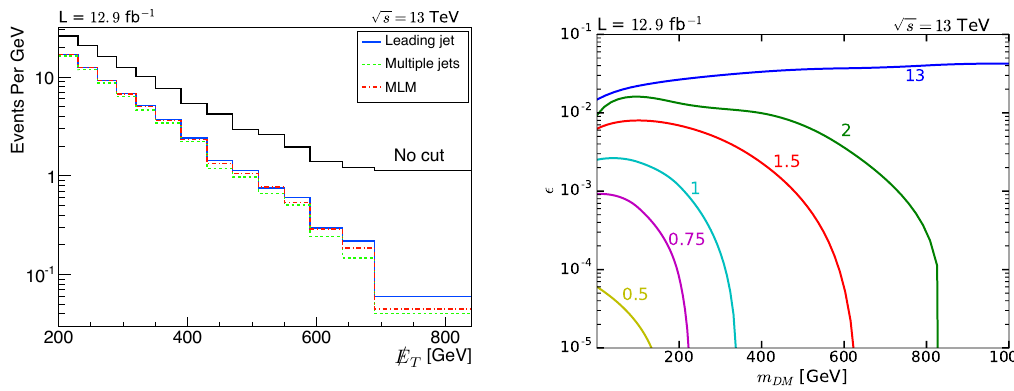
Figure 1 . Left panel: comparison among the three de(cid:12)nitions of E cm described in the text. The distribution without E cm cut is also shown. Right panel: the e(cid:14)ciency (cid:15) as a function of m di(cid:11)erent M cut